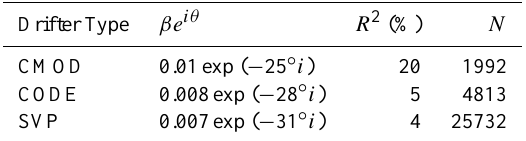
Table 1. Results of the regression model (Eq. 1) applied to extract the wind-driven currents from the velocities of the different types of drifters. R 2 is the coefficient of determination and N is the number of observations